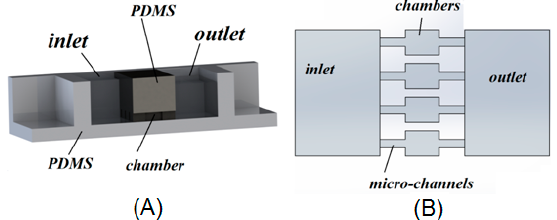
Figure 9. Isometric ( A ) and top views ( B ) of microfluidic system designed for rat glioma cell culturing. Reproduced after [89].